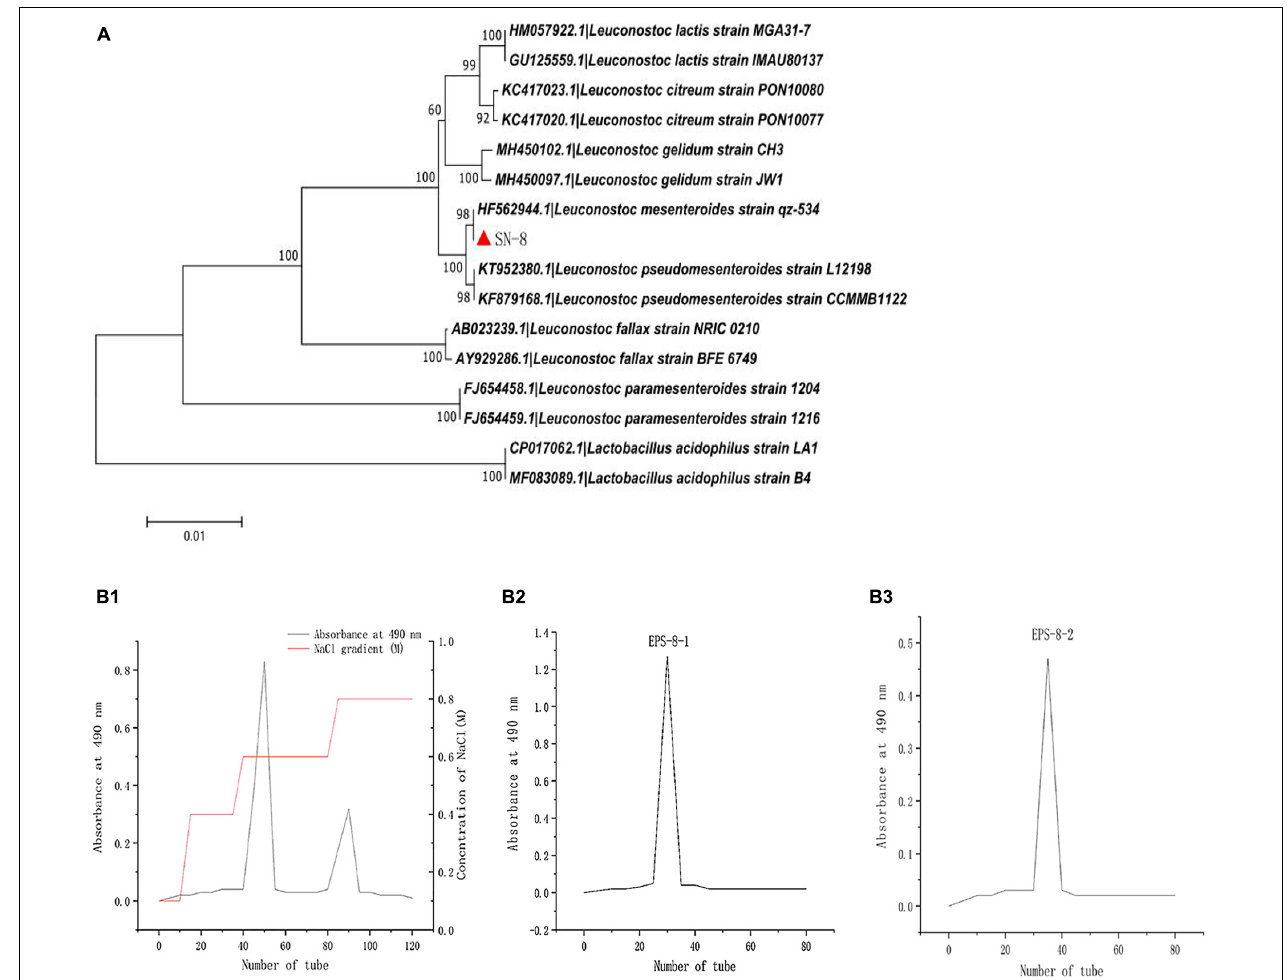
FIGURE 1 | Phylogenetic tree of L. mesenteroides SN-8, based on 16S rDNA sequences (A) and Sebhadex G-100 chromatogram of L. mesenteroiaes SN-8 EPS (B1–B3) .